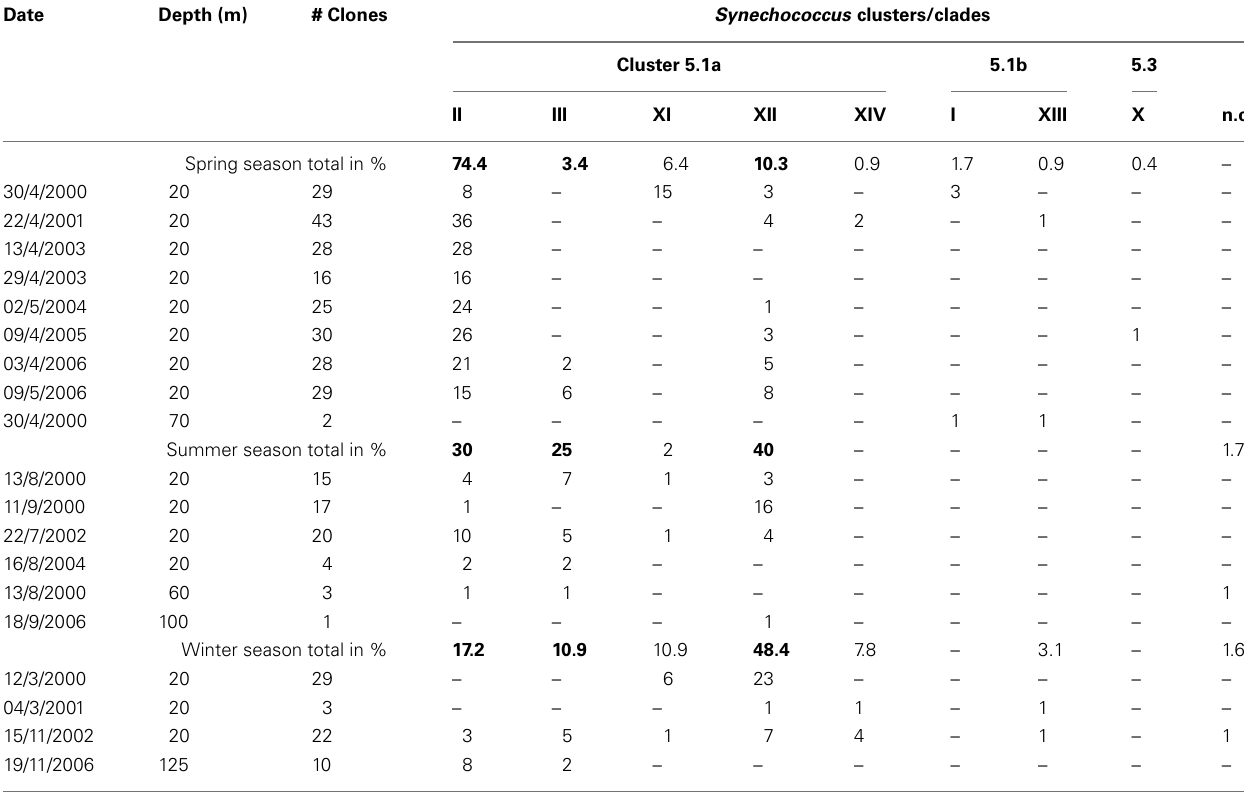
Table 1 | Overview of all unique ntcA sequences and their affiliation with different Synechococcus